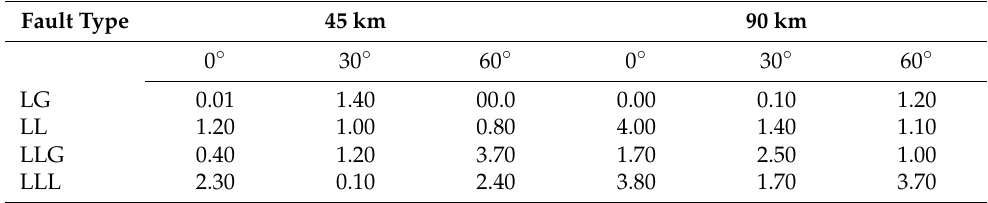
Table 20. AE at 45 and 90 km with a 10 Ω fault impedance with PV and WE sources. Fault Type